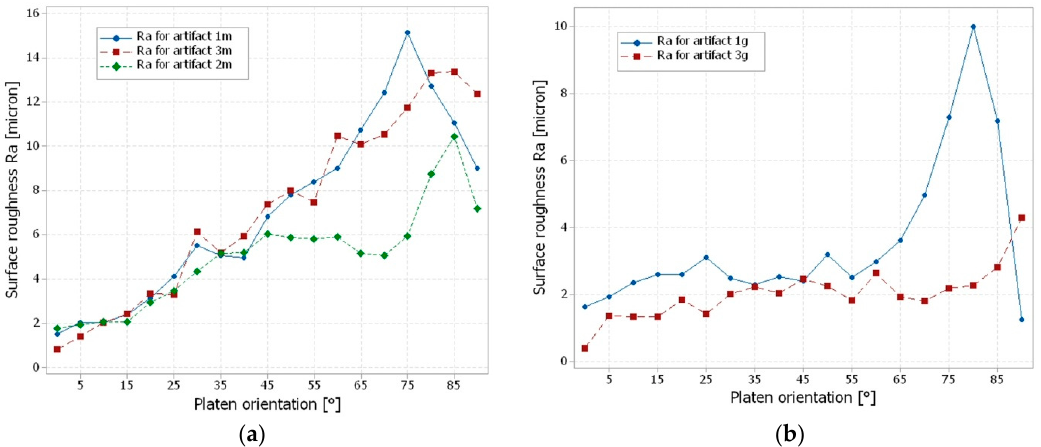
Figure 11. Trends of the measured roughness (Ra): ( a ) artifacts printed in matte finish type; ( b ) artifacts printed in glossy finish type.